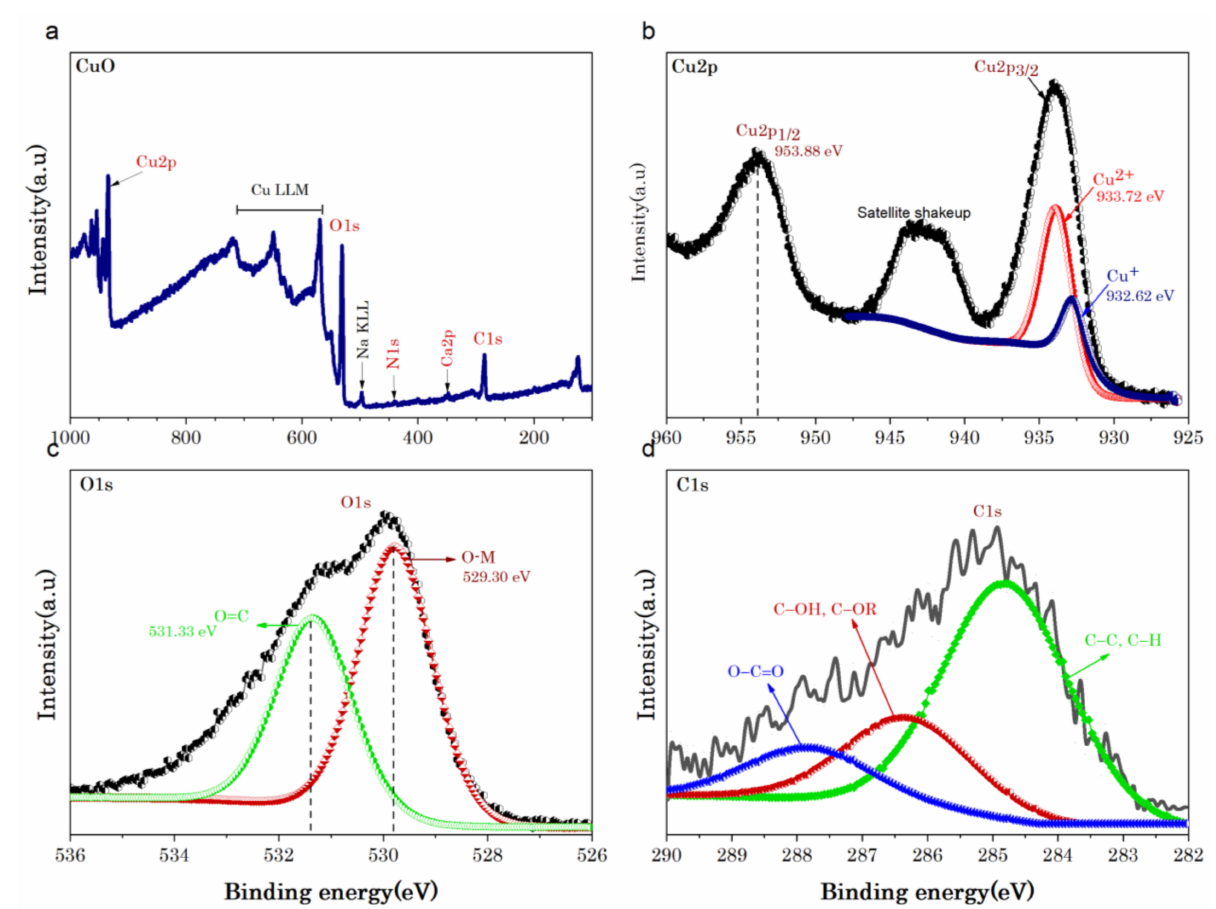
Figure 7. XPS spectra of ( a ) CuO ( b ) Cu2p, ( c ) O1s, and ( d ) C1s associated with 700